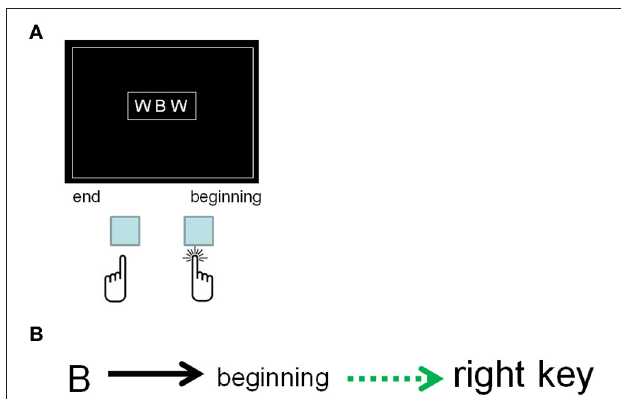
FIGURE 4 | The display used by Cohen-Kdoshay and Meiran (2007). (A) The participants were required to respond to the central letter and ignore the flanking letters. A new rule was instructed in each experimental block. This rule was (for example) to press the right key if the letter came from the beginning of the alphabet and to press the left key if it came from the end of the alphabet. The stimulus in the figure is incongruent because the flankers are associated with a competing response (Congruent displays could be “DBD,” for example). (B) The representation of the instructions, according to our framework consists of activated long-term memory and the region of direct-access (in green), as in Figure 2